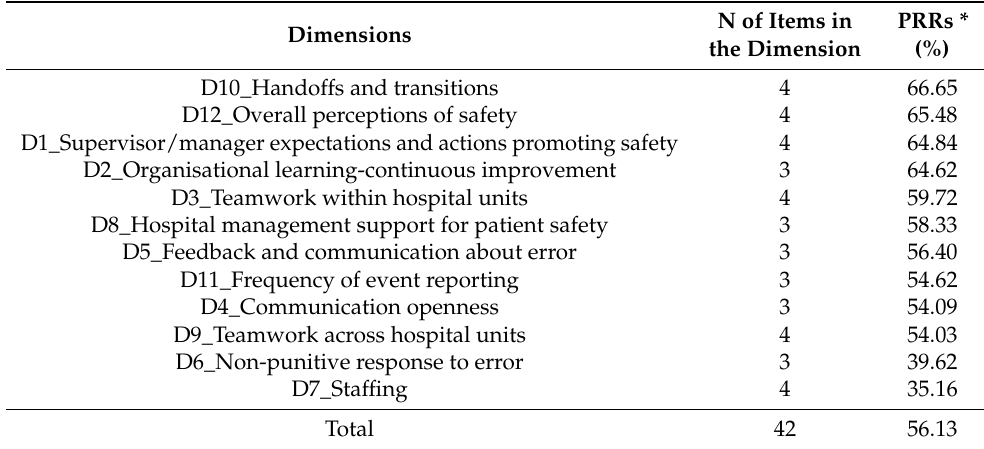
N of Items in PRRs * the Dimension (%)